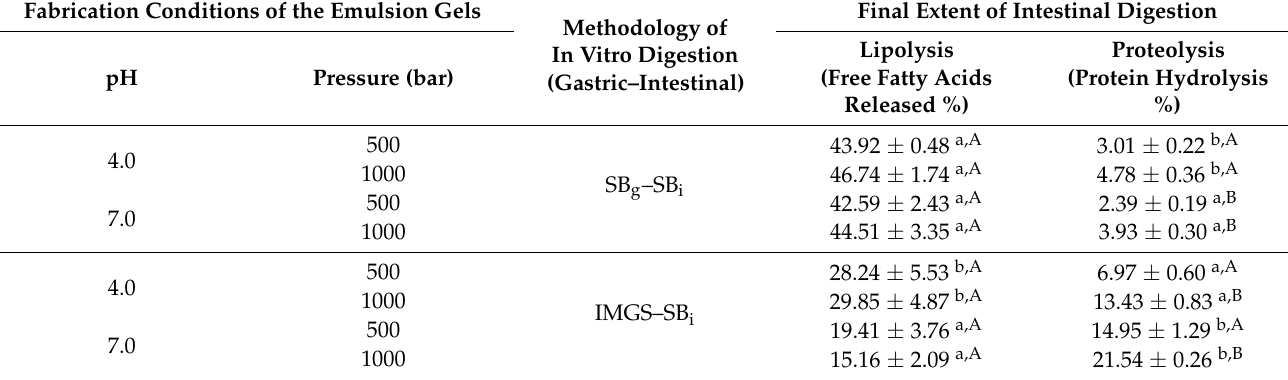
Table 4. Final extent of intestinal lipolysis and proteolysis using different methodologies of in vitro digestion for emulsion gels stabilized by